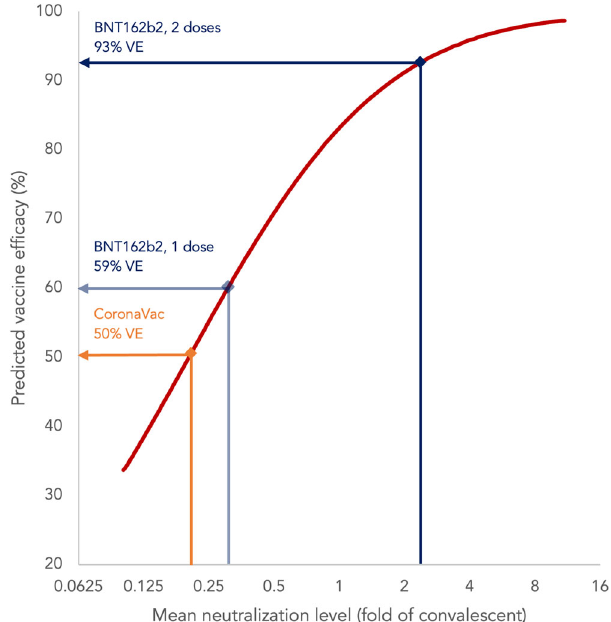
Fig. 5 Vaccine ef fi cacy estimates based on neutralising antibody titres for BNT162b2 (after 1 dose or 2 doses) and CoronaVac (after 2 doses) were ≥ 50% in adolescents. Neutralising antibodies have been established as a reliable correlate of protection that can predict VEs against symptomatic COVID-19. The mean neutralising levels (fold of convalescent) were derived by dividing the geometric mean titres of PRNT90 in healthy evaluable adolescents who received the vaccines with that of 102 convalescent sera collected on days 28 – 59 post-onset of illness in patients aged ≥ 18 years. A point estimate of VE was extrapolated from the best fi t of the logistic model in Khoury et al. 12,38,39 . Adolescent B has been considered completion of primary series, but not adolescent CC or adult B, for a time period in HK and the UK due to elevated myocarditis risks after youths received 2 doses of BNT162b2. Therefore, the VE of adolescent B, but not adolescent C or adult CC, was also extrapolated, along with adolescent BB and CC. The mean neutralisation levels (fold of convalescent) for adolescents after receiving 2 doses of BNT162b2, 2 doses of CoronaVac and 1 dose of BNT162b2 were 2.39, 0.20 and 0.30, respectively. Extrapolation of these mean neutralisation levels using the logistic model resulted in VEs of 93% after 2 doses of BNT162b2, 50%